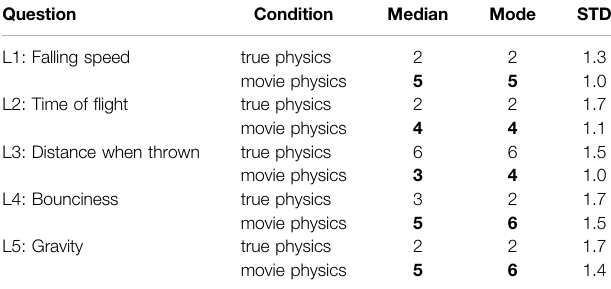
TABLE 6 | Summary of Likert data in Study 2. In L1-L3, responses closer to 4 are perceived as closer to realism, whereas in L4 and L5, responses closer to 7 are perceived as closer to realism. Responses perceived closer to realism are emphasized in